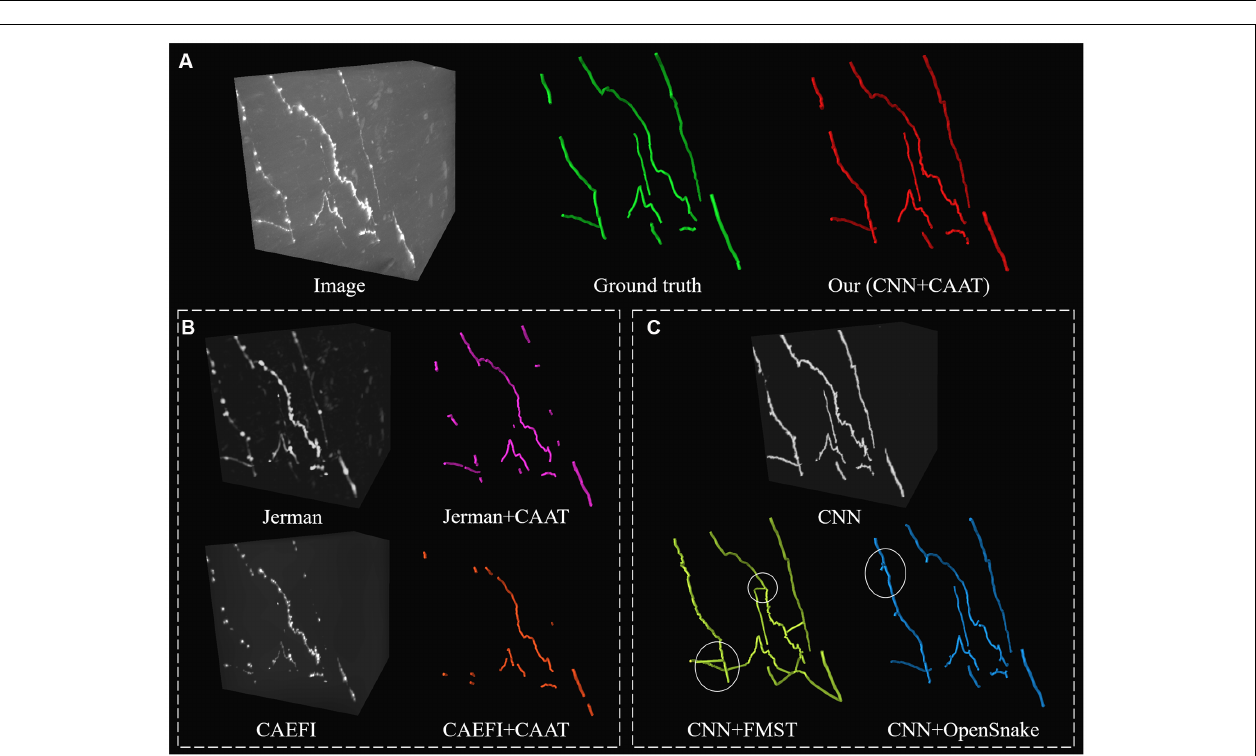
FIGURE 6 | Comparative performances of ablation studies on a discontinuous and noisy fMOST image to illustrate the role of CNN prediction and CAAT of the proposed method, by applying current novel enhancement methods [Jerman filter (Jerman et al., 2015) and CAEFI (Jeelani et al., 2019)] to replace CNN prediction (B) and tracing methods [FMST (Yang et al., 2019) and OpenSnake (Wang et al., 2011)] to replace CAAT (C) alternatively. Comparative tracing results of gold standard and our method (A) . Inaccurate traced areas were marked by white ellipses.